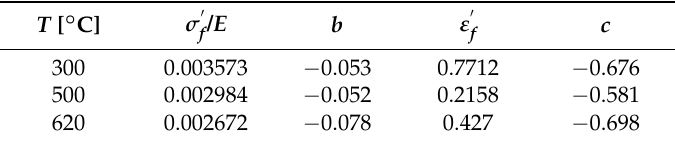
Table 5. Parameters for the Basquin and Manson-Coffin